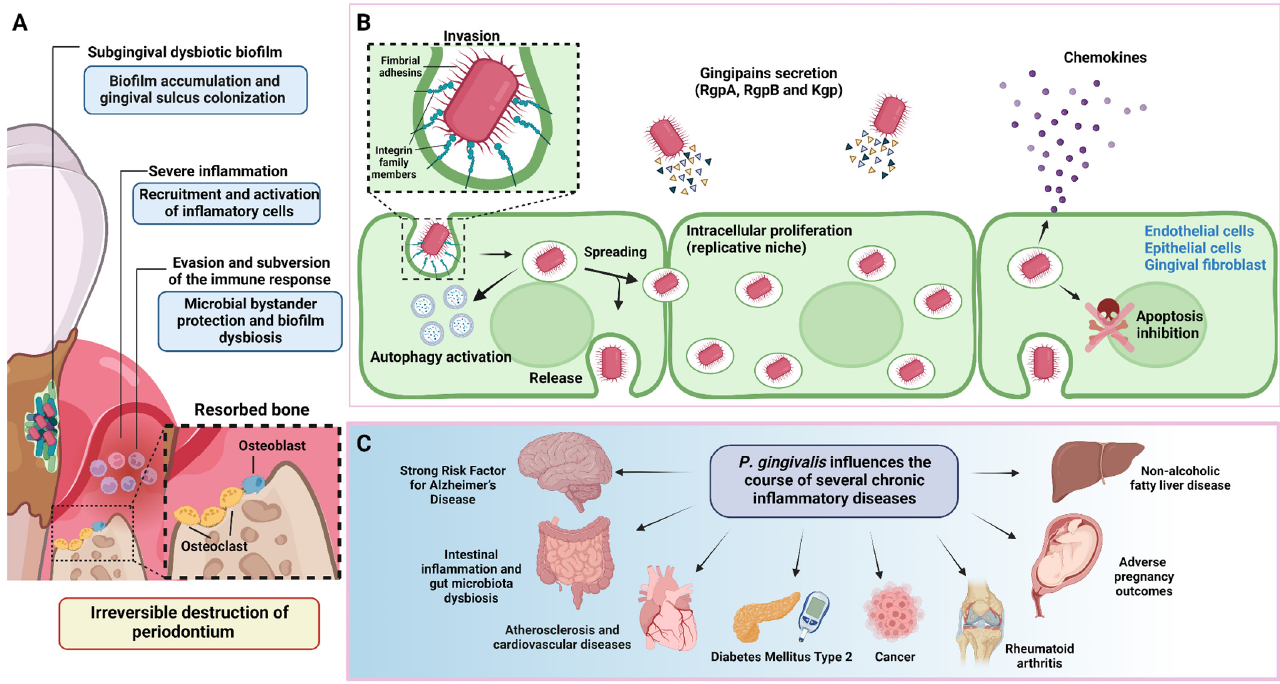
Figure 1. Periodontitis pathogenesis and P. gingivalis overview. ( A ) During the onset and progression of periodontitis, P. gingivalis resides in the subgingival biofilm adhered to the tooth surface, where it interacts metabolically with other bacteria, inducing them to express different virulence factors with pathogenic potential. In parallel, P. gingivalis acts as a keystone pathogen, altering the regulation of the immune response in the susceptible host. The metabolic synergism and immune response subversion provide the nutritional and protective conditions required by the dysbiotic subgingival community to increase their diversity and abundance, with the concomitant induction of a strong, destructive inflammatory response. Together, all these activities cause irreversible connective tissue breakdown and resorption of the tooth-supporting alveolar bone, the critical hallmark of periodontitis that causes tooth loss. ( B ) To invade the periodontium, P. gingivalis uses various virulence factors that allow it to colonize, replicate, and spread in different subsets of cells to increase its progeny and generate infection. ( C ) In addition to causing tooth loss, P. gingivalis -induced periodontitis can also affect systemic health, influencing the course of other diseases and conditions. This figure was created using BioRender.com.